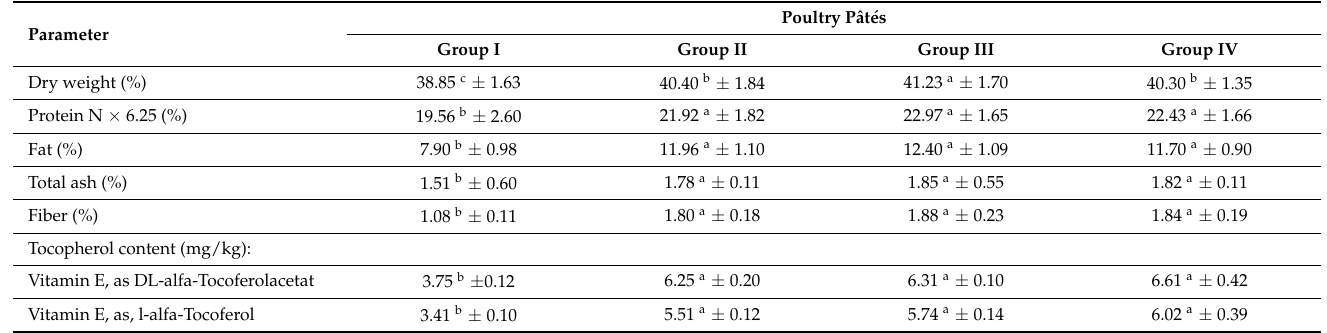
Table 3. Effect of the addition of hemp seeds, amaranth and golden flaxseed on the basic chemical ¯ composition of poultry p â t é s ( x ± s).